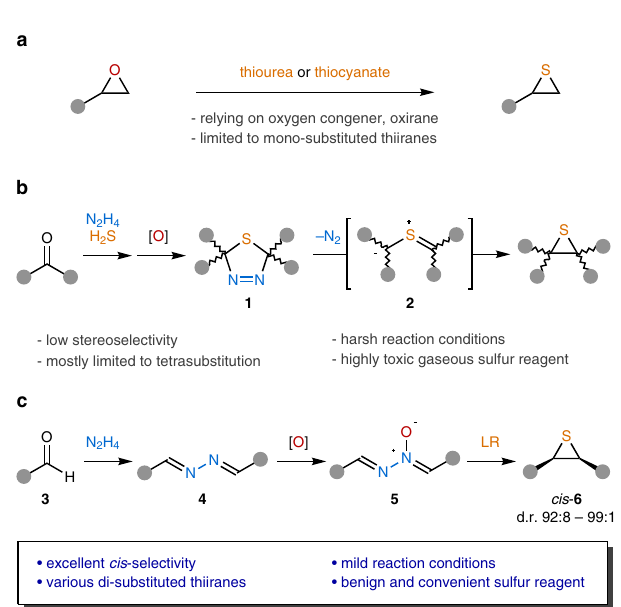
Fig. 2 | Approach to stereoselective synthesis of thiiranes. a Common method for thiirane synthesis. b Previous approach to thiiranes via the intermediacy of thiocarbonyl ylides. c This work: Diastereoselective synthesis of cis -thiiranes from aldazine N -oxides. LR Lawesson ’ s reagent, d.r. diastereomeric